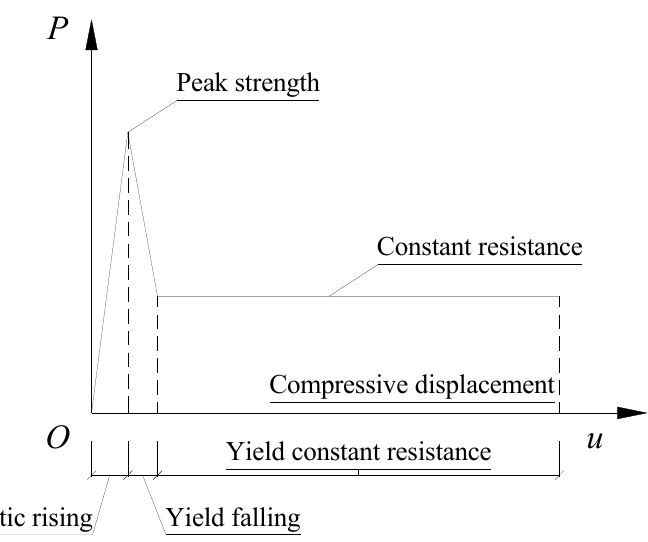
Figure 12. The stress–deformation curve of the three energy-absorbing dampers.